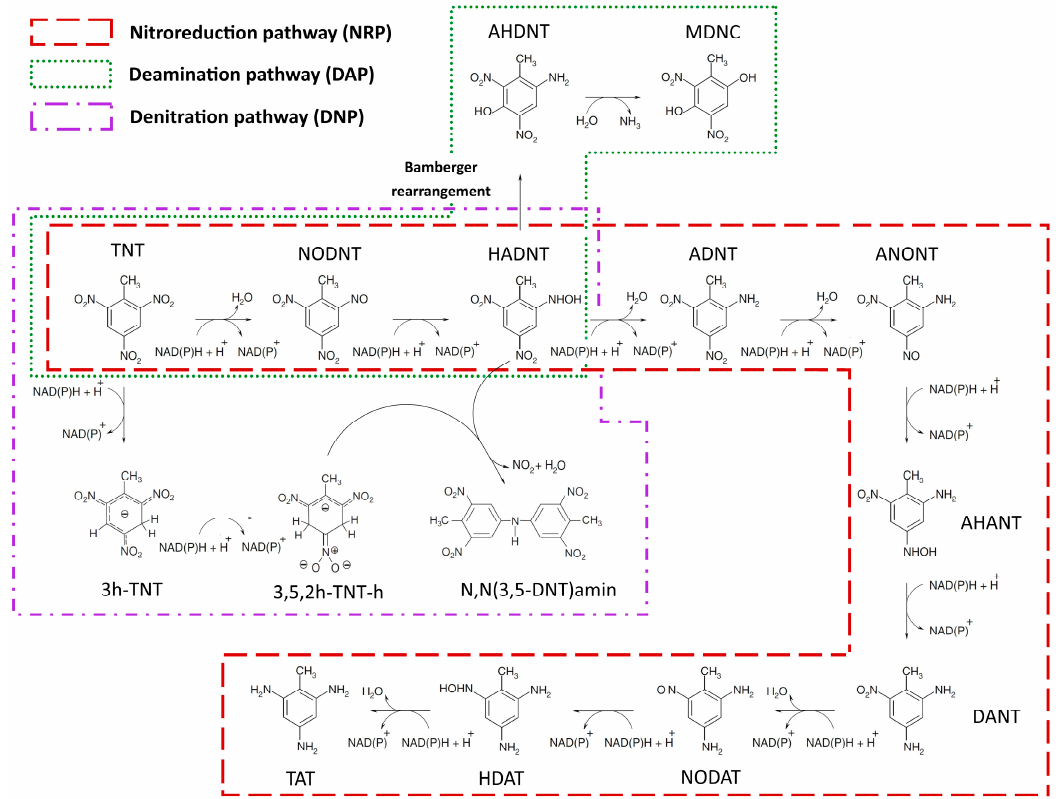
Figure 1. The representative TNT biotransformation pathways known or evidently hypothesized to operate in E. coli in the presence of TNT [1–3,9,13,27–30,44,45].